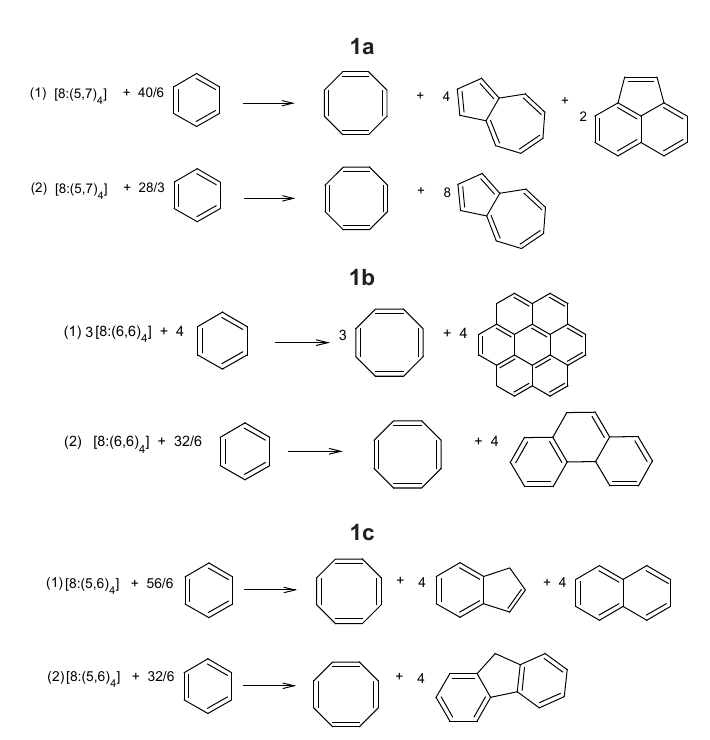
Figure 3. (cid:44)(cid:86)(cid:82)(cid:71)(cid:72)(cid:86)(cid:80)(cid:76)(cid:70)(cid:3)(cid:85)(cid:72)(cid:68)(cid:70)(cid:87)(cid:76)(cid:82)(cid:81)(cid:86)(cid:3)(cid:73)(cid:82)(cid:85)(cid:3)(cid:70)(cid:68)(cid:79)(cid:70)(cid:88)(cid:79)(cid:68)(cid:87)(cid:76)(cid:81)(cid:74)(cid:3)(cid:87)(cid:75)(cid:72)(cid:3)(cid:80)(cid:68)(cid:74)(cid:81)(cid:72)(cid:87)(cid:76)(cid:70)(cid:3)(cid:86)(cid:88)(cid:86)(cid:70)(cid:72)(cid:83)(cid:87)(cid:76)(cid:69)(cid:76)(cid:79)(cid:76)(cid:87)(cid:92)(cid:3)(cid:72)(cid:91)(cid:68)(cid:79)(cid:87)(cid:68)(cid:87)(cid:76)(cid:82)(cid:81)(cid:3)(cid:76)(cid:81)(cid:3)(cid:288)(cid:82)(cid:90)(cid:72)(cid:85)(cid:86)(cid:3) 1a to 1c . Table 4. Computed values of the isotropic magnetic susceptibilities (6-311G(d,p)) and experimental exaltations of the magnetic susceptibility (for the molecules in the six isodesmic reactions – Fig. 3). Compound